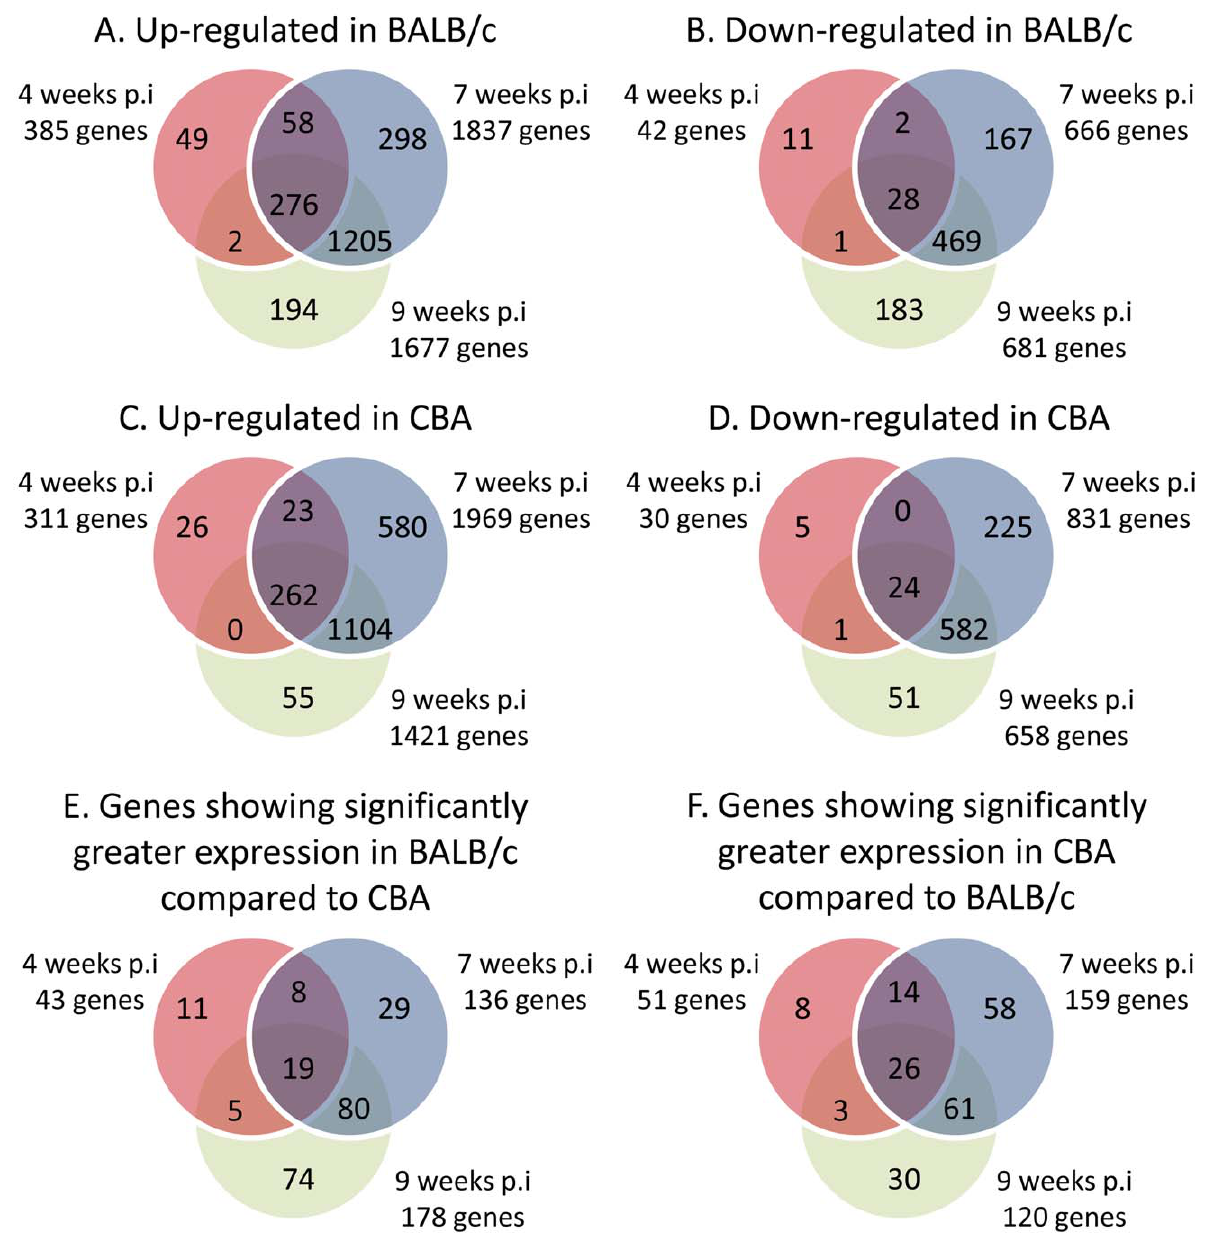
Figure 5. Venn diagrams to illustrate the overlap between genes showing significantly altered expression. A and B are derived from the list of 2,937 genes which were significantly changing over time in BALB/c mice (2-Way ANOVA, p , 0.05). A shows the overlapping expression of genes within this 2,937 gene list that were significantly up-regulated at either 4, 7 or 9 weeks p.i. B demonstrates the overlap of expression for genes which were down-regulated at either 4, 7 or 9 weeks p.i. Similarly, C and D correspond to the 2,938 genes showing differential expression over time in CBA mice (2-Way ANOVA, p , 0.05), where C represents up-regulated genes and D represents down-regulated genes. The majority of these genes show overlapping expression between 7 and 9 weeks p.i. E and F represent the 687 genes which were differentially expressed between strains (2- Way ANOVA, p , 0.05). E depicts the overlapping expression of genes which were more highly expressed in BALB/c mice at either 4, 7 or 9 weeks p.i. F demonstrates the overlapping time-points at which genes transcribed at much higher levels in CBA mice were